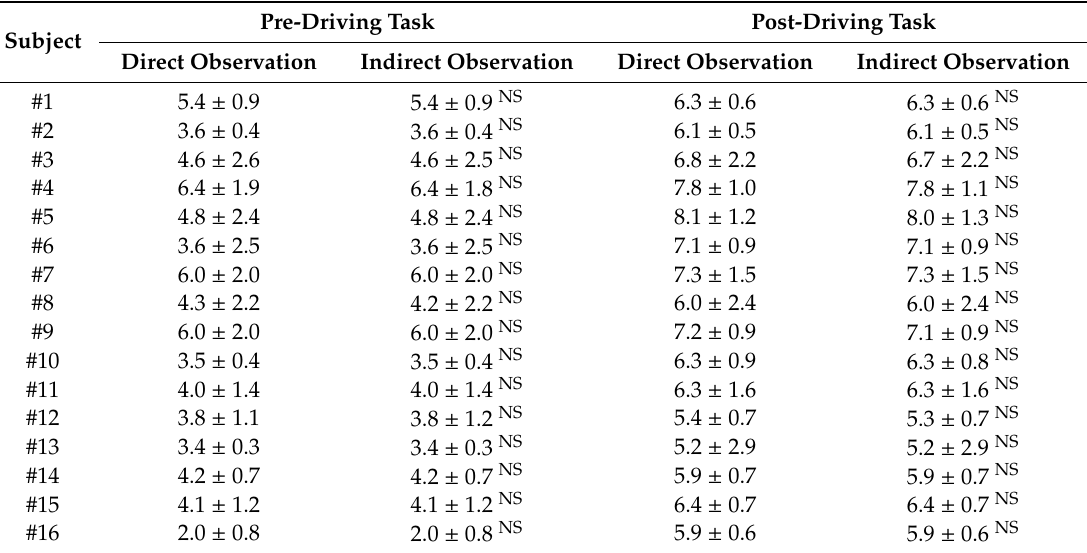
Table 1. Validation of similarity between KSS evaluated from direct and indirect observation.